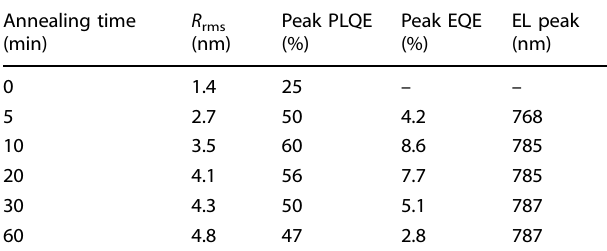
Table 1. Film properties of MQW perovskites processed with different annealing time and the corresponding LED device performance Annealing time